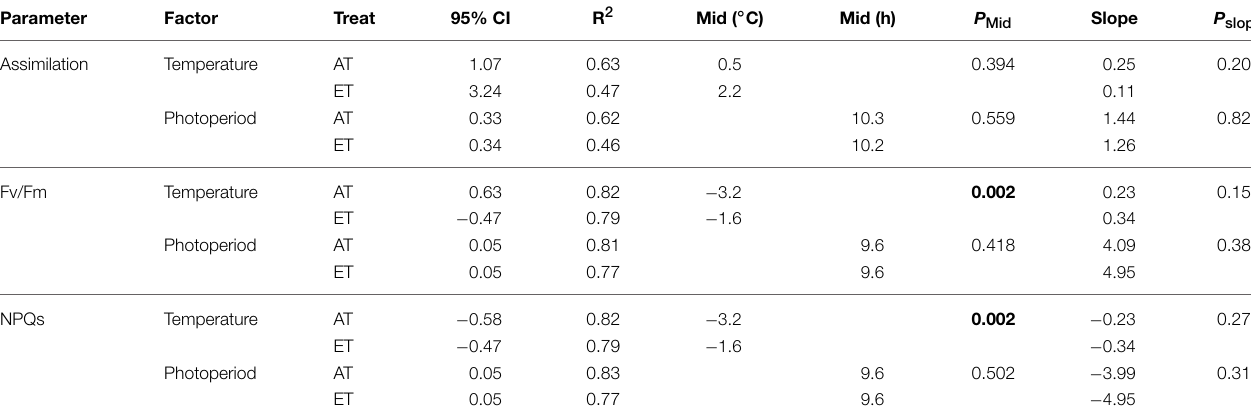
NPQs Temperature Photoperiod